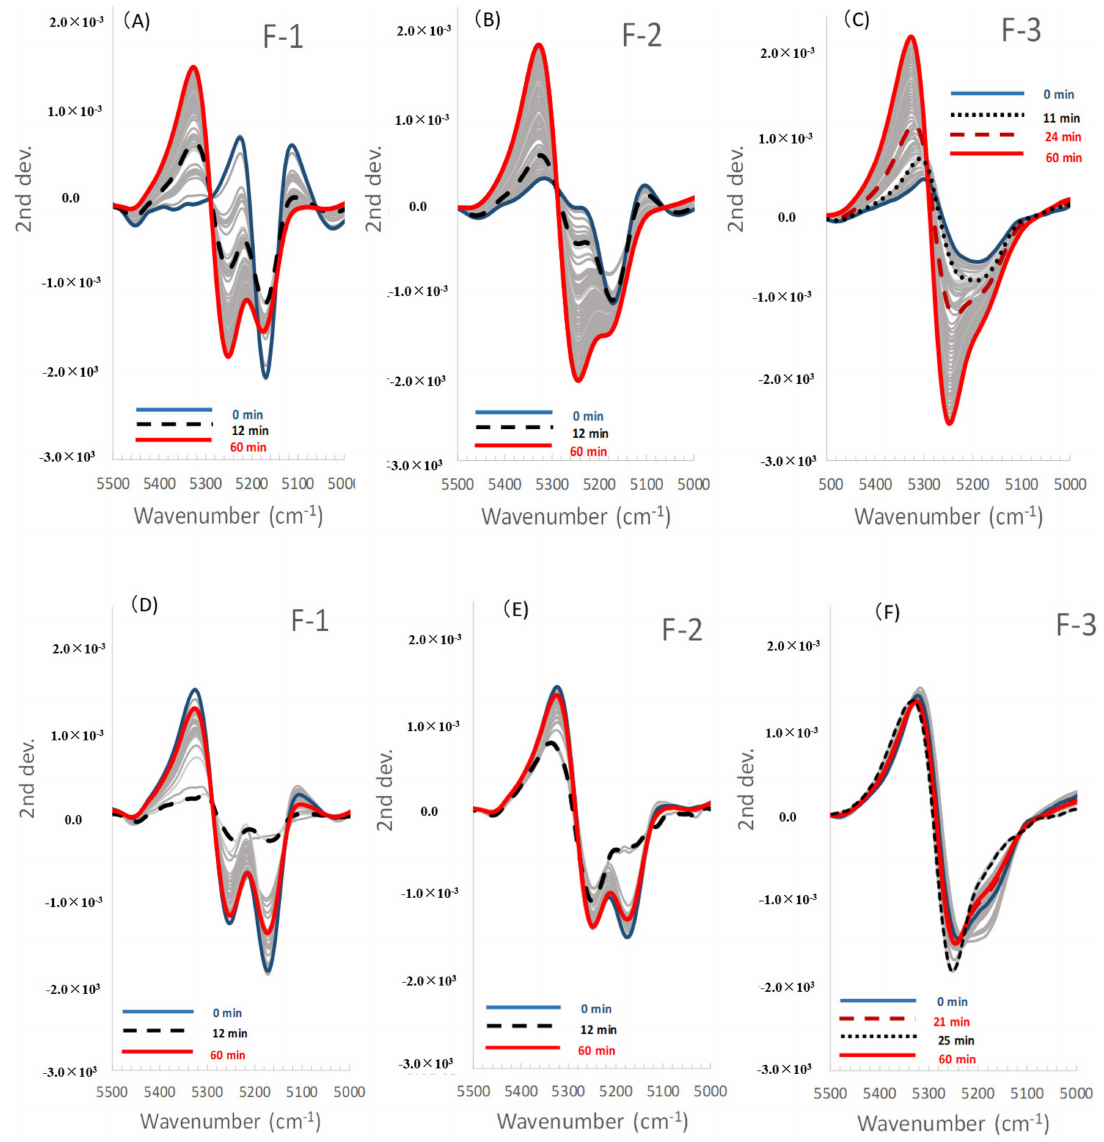
Figure 10. ( A – C ) Reconstructed near-infrared spectra for the band 5000–5500 cm − 1 obtained based on chemometric parameters of the best-fitted calibration models for all formulations. ( A – C ), the amount of water for lactose, mixture, and starch samples. ( D – F ) Reconstructed near-infrared spectra for the band 5000–5500 cm − 1 obtained based on chemometric parameters of the best-fitted calibration